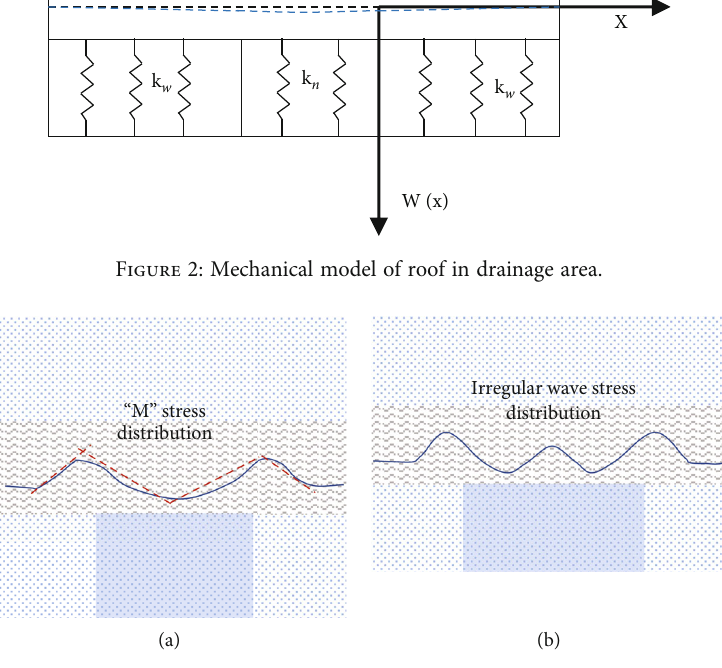
Figure 3: Schematic diagram of stress distribution of di ff erent drainage zone widths.